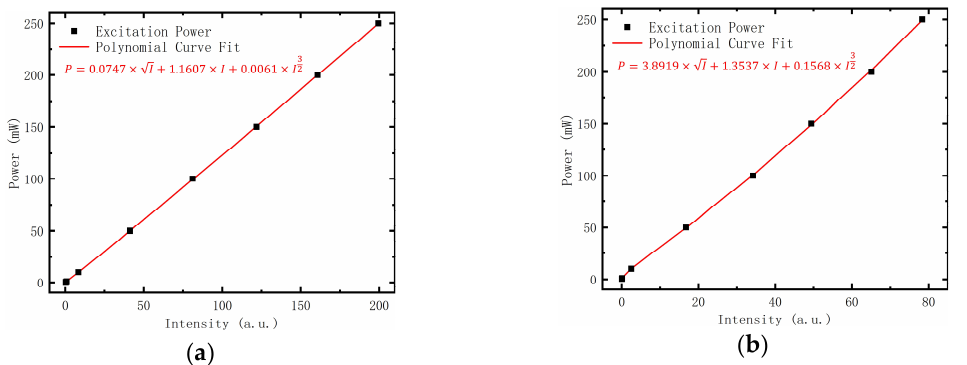
Figure 4. ( a ) Polynomial curve fit of power dependent photoluminescence (PDPL) results at low temperature (LT); ( b ) Polynomial curve fit of PDPL results at room temperature (RT). Auger recombination (the third term of the polynomial) should be considered otherwise the coefficient of determination will become worse.